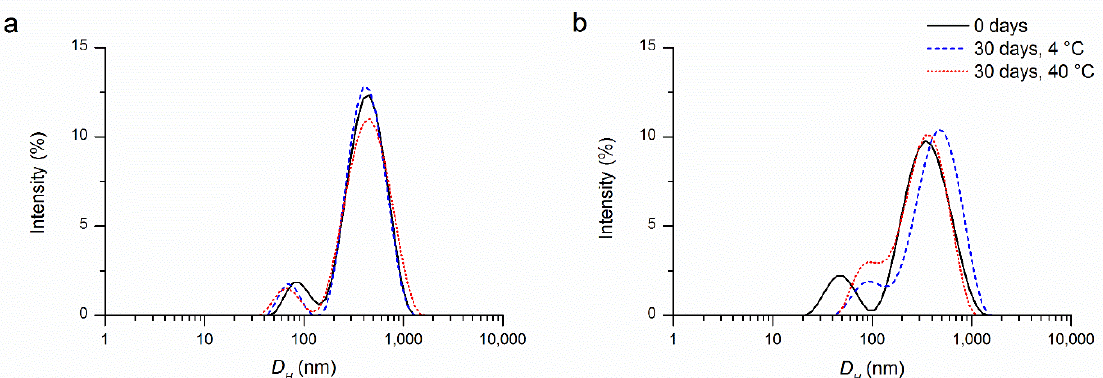
Figure 1. Intensity weighted distribution of the hydrodynamic diameter ( D H ) of ( a ) Th-CNPs and ( b ) Or-CNPs at different storage conditions.